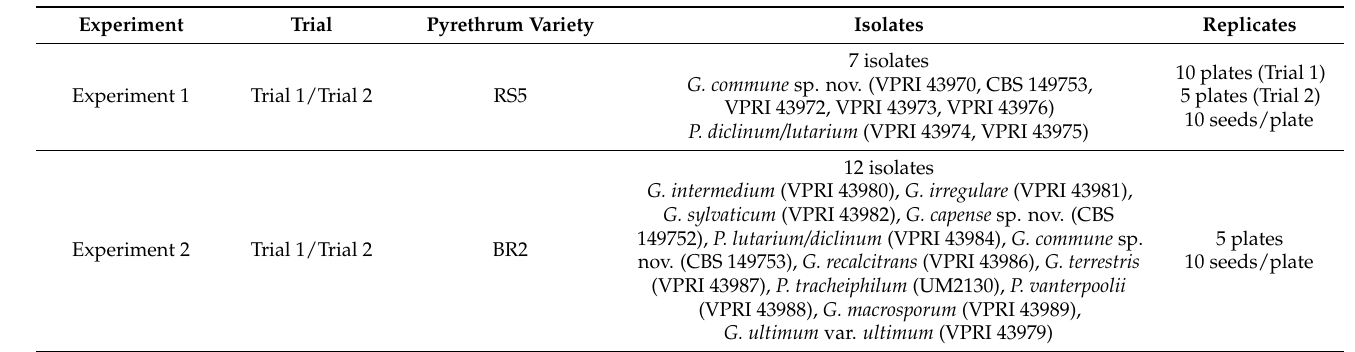
Table 5. In vitro pre-germination bioassays of pyrethrum seed inoculated with Globisporangium and Pythium